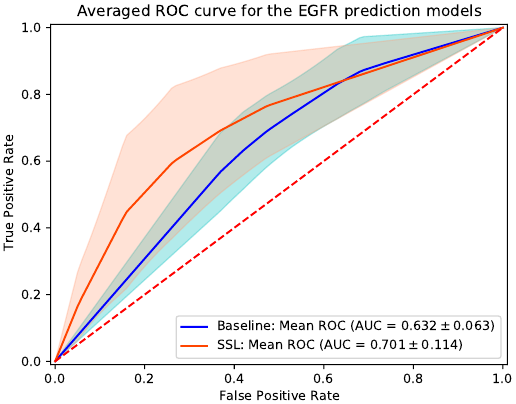
Figure 5. Averaged ROC curve for EGFR mutation status prediction with the baseline and best- performing SSL model. For each train-test split, the ROC curve is computed. The blue and orange lines represent the arithmetic average ROC curve for each model, and the shaded areas depict the corresponding standard deviation. The red dashed line illustrates the ROC curve of an at- chance